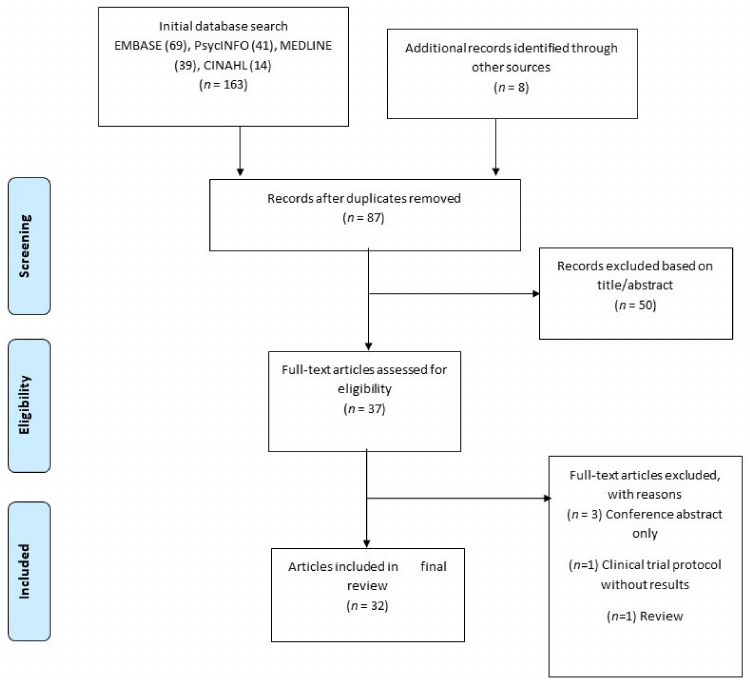
Figure 1. Summary of search